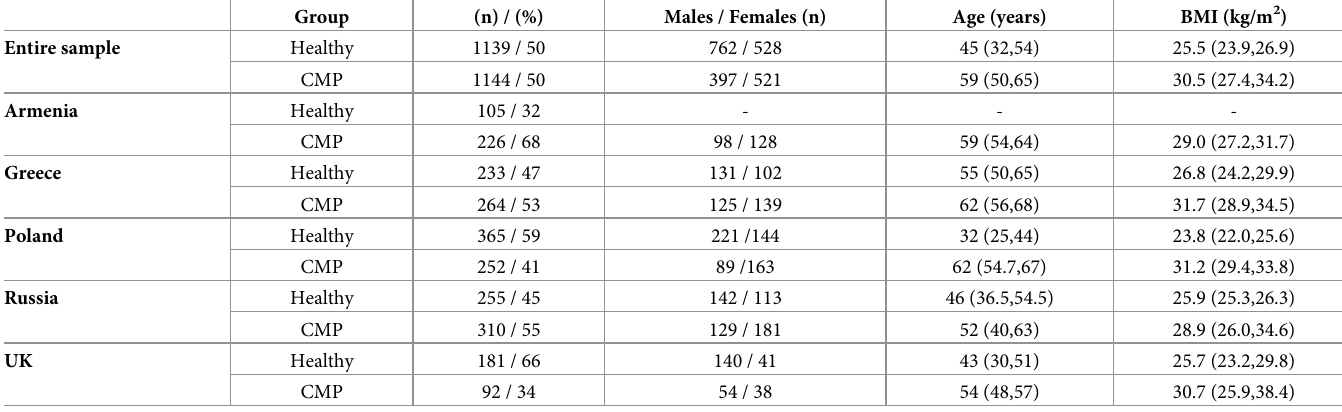
Table 1. Characteristics of the studied